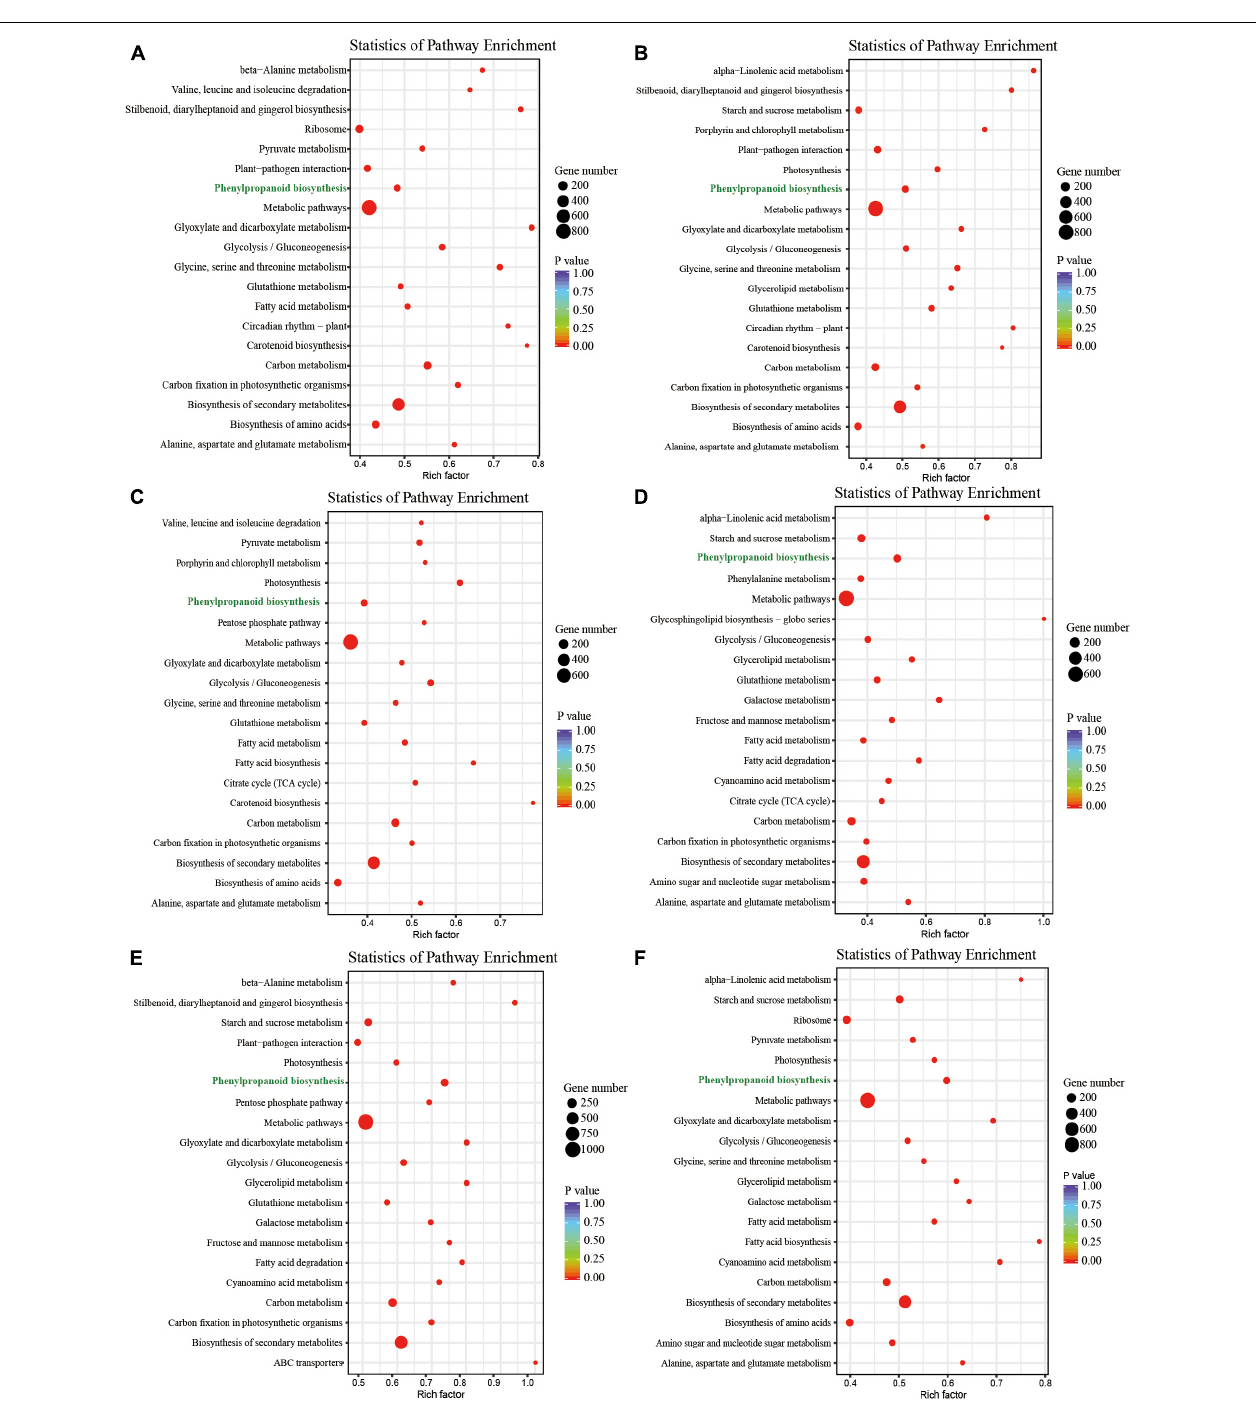
FIGURE 1 | KEGG pathway enrichment analysis of DEGs in the six comparison groups. (A–F) KEGG pathway enrichment analysis of DEGs in the petal vs. leaf, pistil vs. leaf, pistil vs. petal, pistil vs. stamen, stamen vs. leaf, and stamen vs. petal comparisons, respectively.